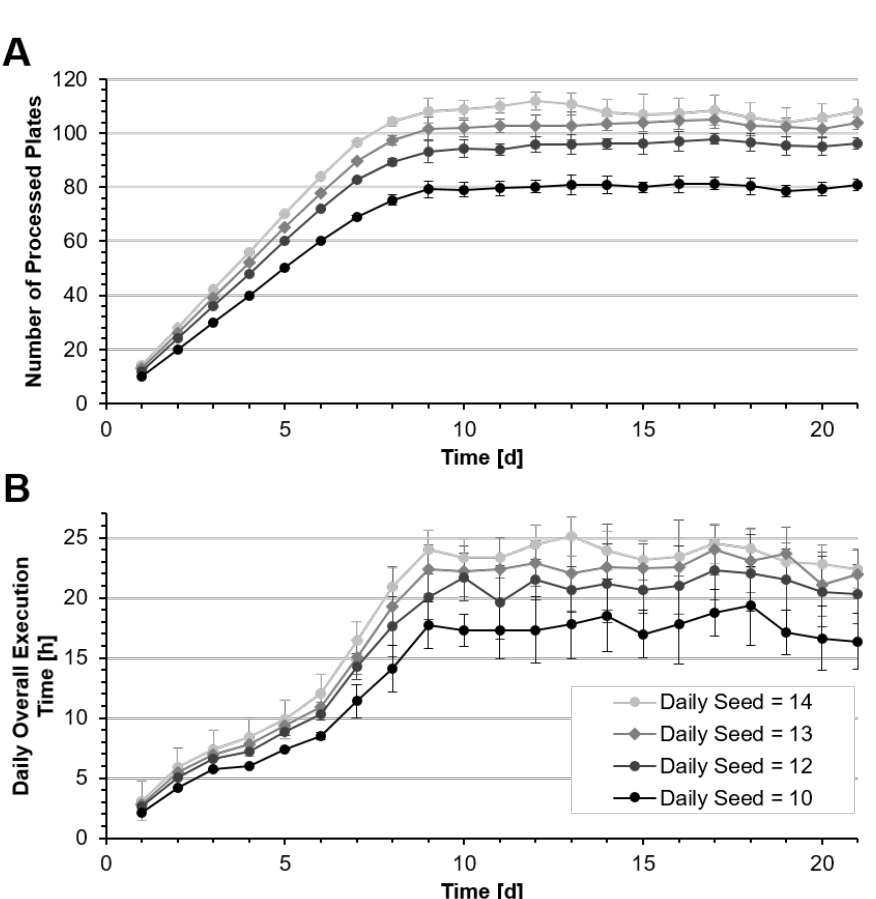
Figure 8. Results for the simulation of the production environment for 21 days with daily seedings of 10–14 plates. Each plate list was generated randomly with variation in seeding density, growth rates and processing times for each plate. In order to provide information on average processing times and deviations, a Monte Carlo approach was chosen and the simulation was repeated. For every plate list length, one hundred plate lists with the same length were generated. From all iterations, the averages and standard deviation were calculated. ( A ) Average plate number in the system achieved during the simulation. For all daily seedings, a steady state is reached after approximately nine days, when the plate number stays about the same. ( B ) Overall execution time required to process all plates in the system at the respective time. Table 3. Average system utilization for days 9–21 of the simulation with daily seedings of 10–14 plates. These results indicate that, on average, the system would be able to process at least 95 plates within 24 h. While it would be feasible to process up to 108 plates daily on average, the overall process durations can exceed 24 h at times due to the inherent culture variability, which can cause delays and additional bottlenecks.